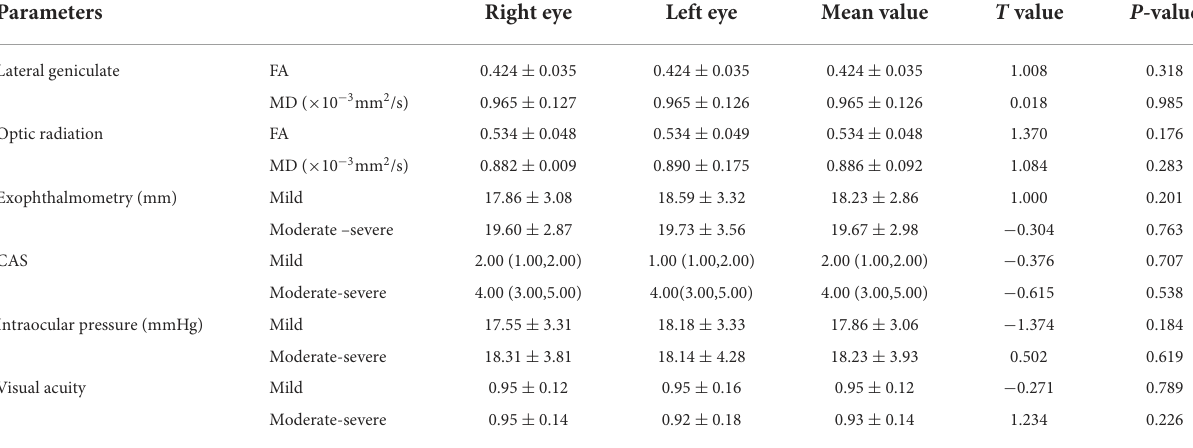
TABLE 2 Comparison of left and right visual pathway and clinical parameters. Parameters